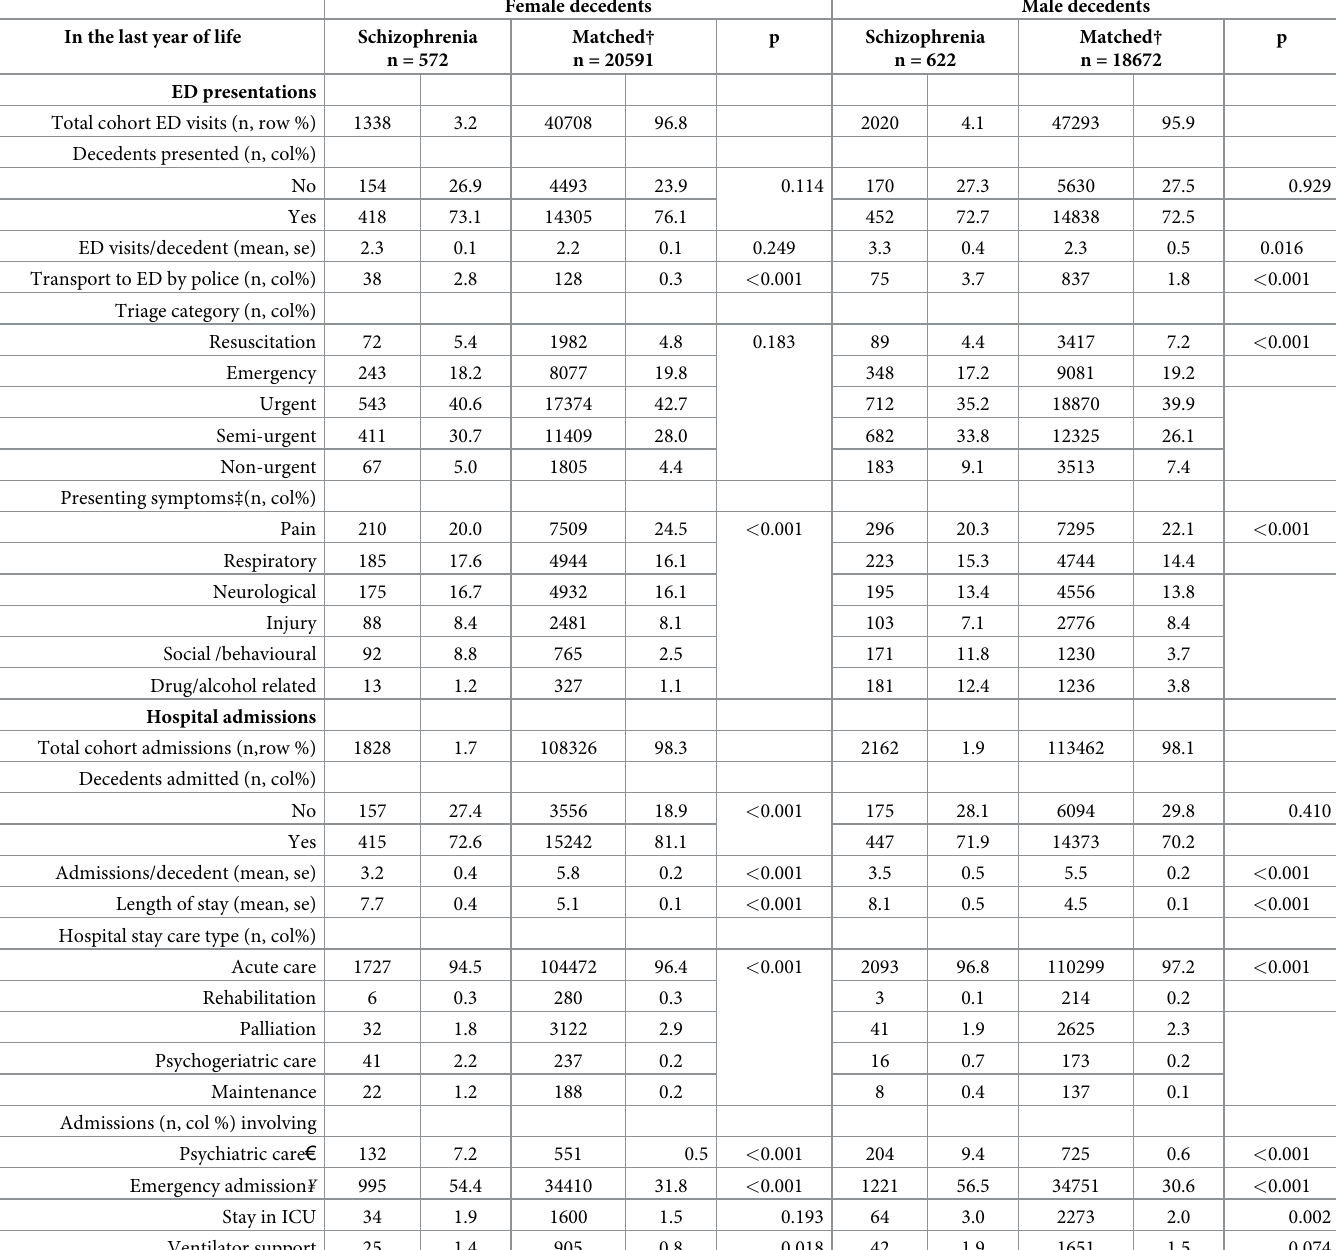
Table 4. Summary characteristics of ED presentations and hospital stays in the last year of life for decedents in the schizophrenia and matched comparison cohort stratified by sex. Female decedents Male decedents In the last year of